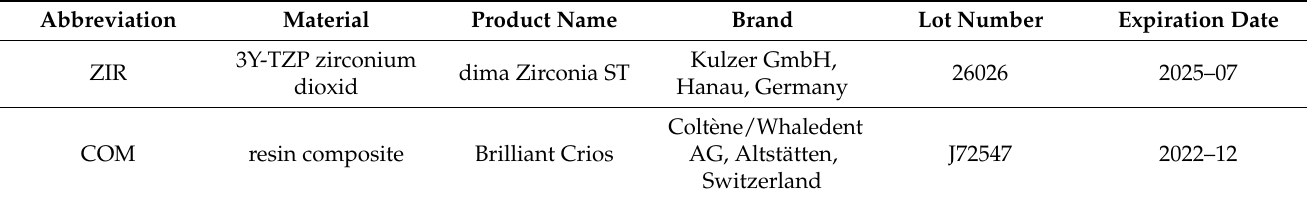
Table 1. Materials for